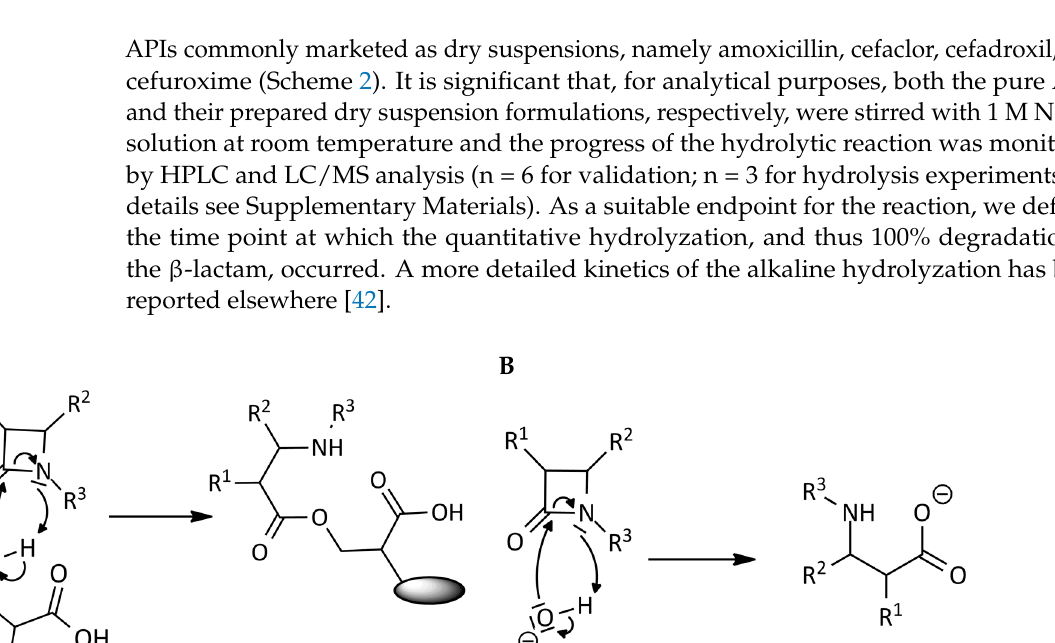
B Figure 1. ( A ) Molecular mechanism of action of β‐ lactams towards acylation of a key serine residue within the active site of PBPs. ( B ) Hydrolytic reaction of the β‐ lactam ring induced by a hydroxide ion to yield antibiotically inactive penicillic acid, and downstream further polar degradation products. 2.2. Targeted Hydrolysis of the β‐ Lactam